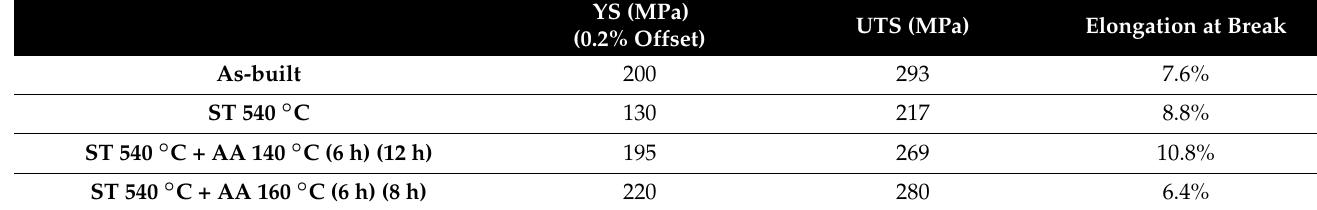
Table 2. Tensile Properties of AlSi10Mg Specimens.